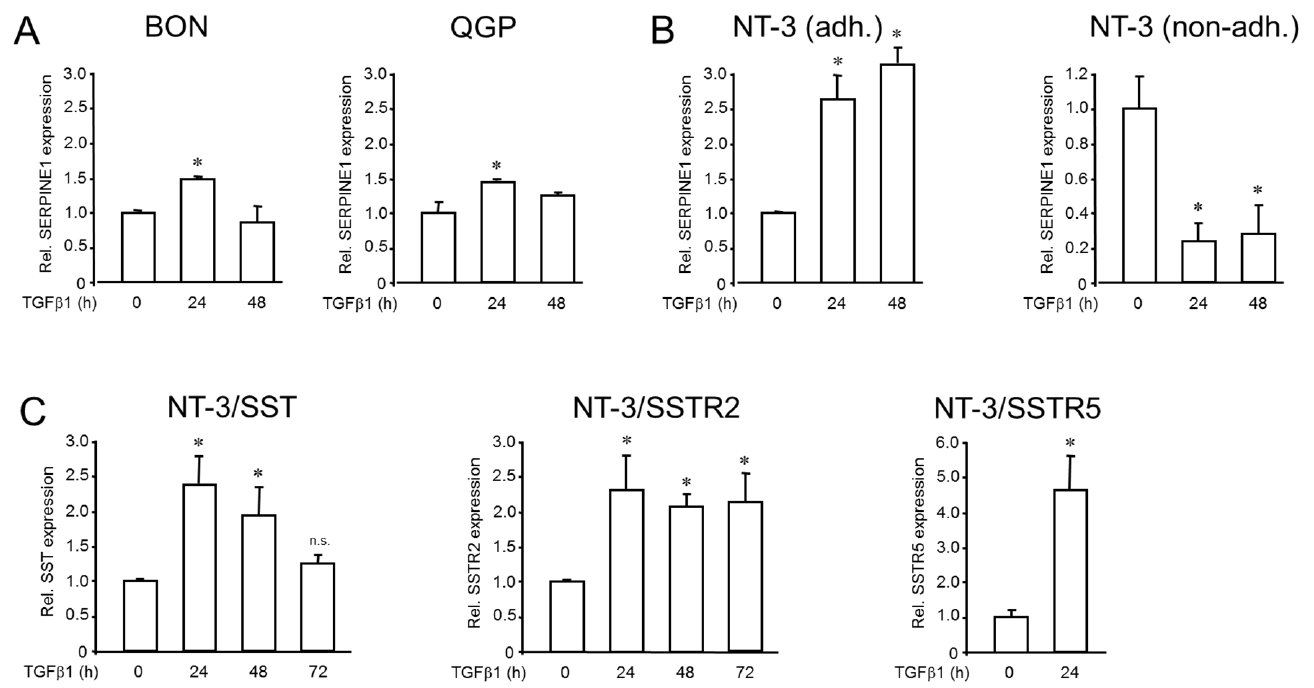
Figure 2. Effect of TGF- β 1 treatment on expression of SERPINE1, SST, SSTR2, and SSTR5 in BON, QGP, and NT-3 cells. Cells were challenged with TGF- β 1 (5 ng/mL) for the indicated times, followed by RNA isolation and qPCR analysis: ( A ) SERPINE1 in BON and QGP cells. ( B ) SERPINE1 in adherent (adh.) and non-adherent (non-adh.) NT-3 cells. Data in A-B represent the mean ± SD of four independent assays ( p < 0.05, Wilcoxon test) relative to the untreated (0) control cell set at 1.0. ( C ) SST, SSTR2, and SSTR5 expression in NT-3 cells as measured by qPCR analysis. The data shown are from a representative assay out of three assays performed in total (mean ± SD after normalization to TBP and relative to untreated control cells set at 1.0). The asterisks (*) denote a significant difference ( p < 0.05, Student’s t -test).